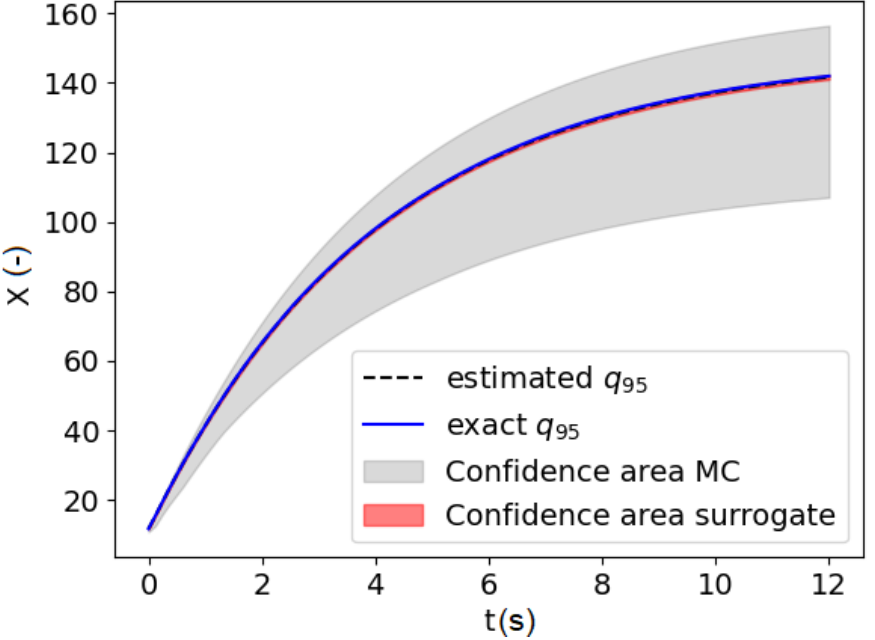
Figure 11. Confidence area based on the surrogate model estimation and based on Monte Carlo (MC) with 14 evaluations of Q X ( · )